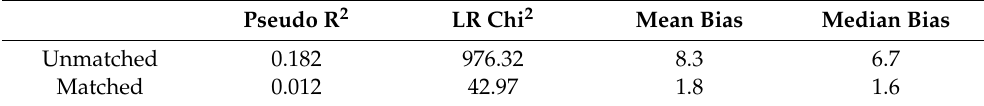
Table 3. Results of balancing test before and after matching.